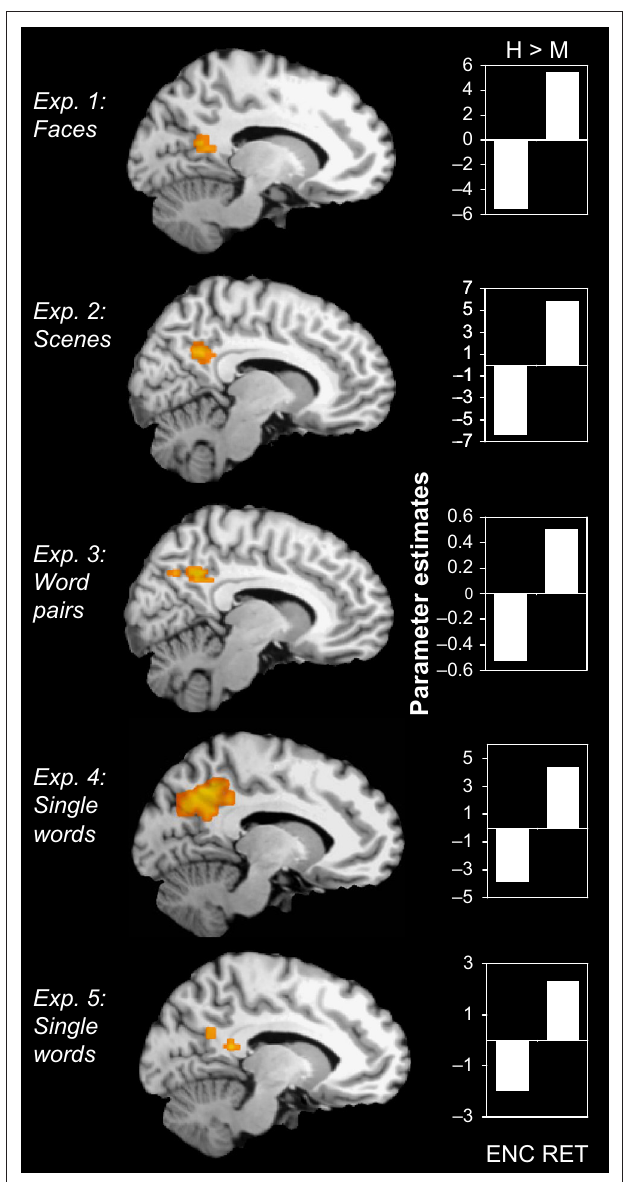
FIGURE 1 | Encoding/retrieval fl ip in PMR. Consistent results in fi ve different fMRI experiments: During encoding, activity in the posterior midline region (PMR) was greater for misses (M) than for hits (H), whereas during retrieval, activity was greater for hits than for misses. Bar graphs indicate mean cluster activity for the comparison between hits and misses during encoding and retrieval,